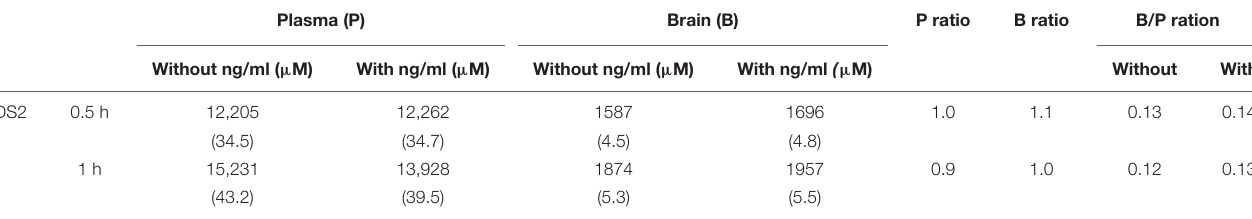
FIGURE 3 | DS2 decreases pro-inflammatory cytokine production post-stroke. Mice were injected i.p. with vehicle or DS2 (0.1, 1 or 4 mg/kg) 1 and 24 h after induction of stroke and peripheral blood collected from the tail vein of mice 3-days post-stroke. Sera were analyzed for (A) IL- β , (B) TNF- α , (C) IL-6, and (D) IL-17 concentrations using a BioPlex kit. Data are expressed as mean ± SD for n = 5 per group. ∗∗∗ P < 0.001, ∗∗ P < 0.01, ∗ P < 0.05 compared to vehicle. +++ P < 0.001, ++ P < 0.01, + P < 0.05 compared to sham control. TABLE 2 | Brain and plasma concentrations following DS2 administration and co-treatment with or without